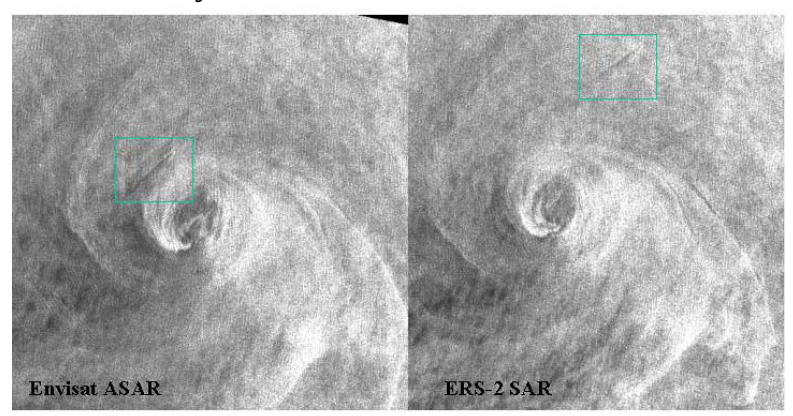
Figure 6. ENVISAT and ERS-2 SAR subscenes (28 km × 28 km) collected on April 27, 2005 north of Philippines in the Luzon Strait. The almost invisible ship and its wake near the eddy can be tracked